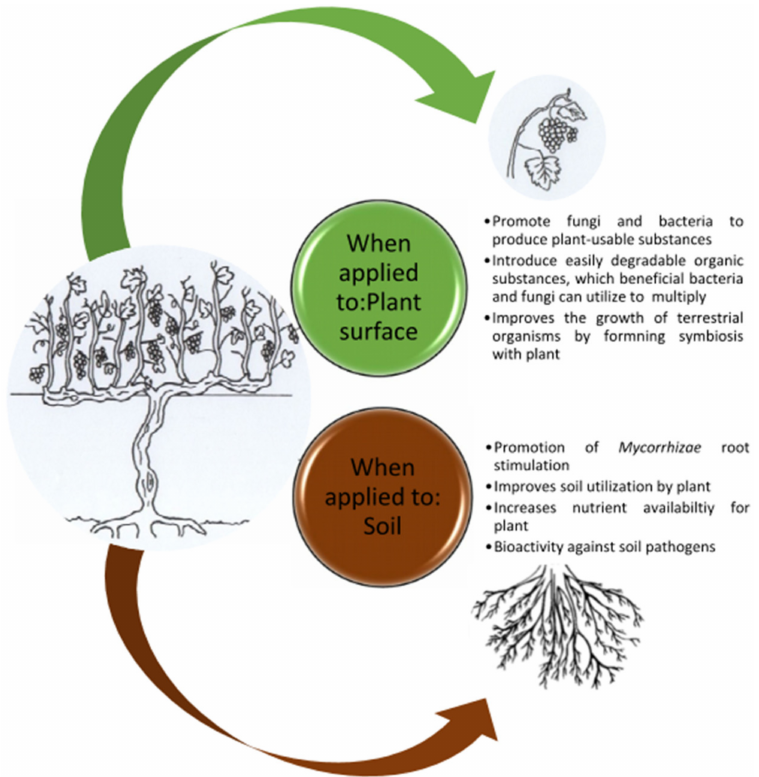
Figure 5. Rhizopshere benefits of the application of seaweed extract